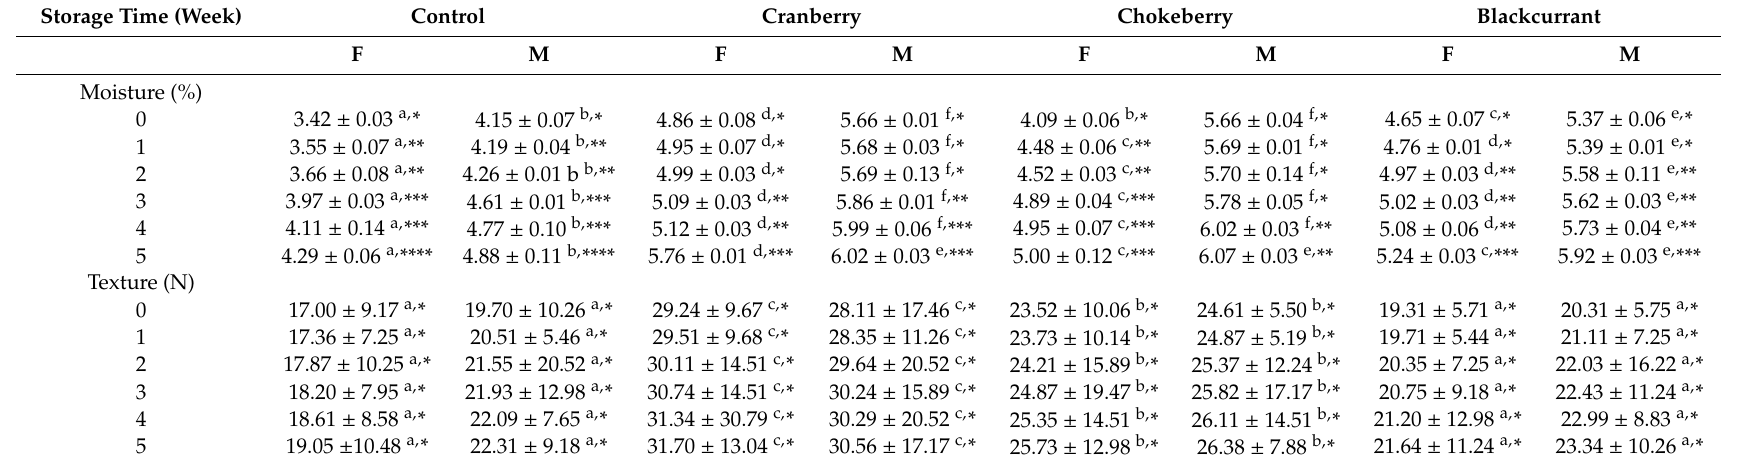
Table 1. Moisture content (%) and the texture (N) of fried and microwaved snacks made from Jerusalem artichoke flour with addition of fruit powders during storage for 5